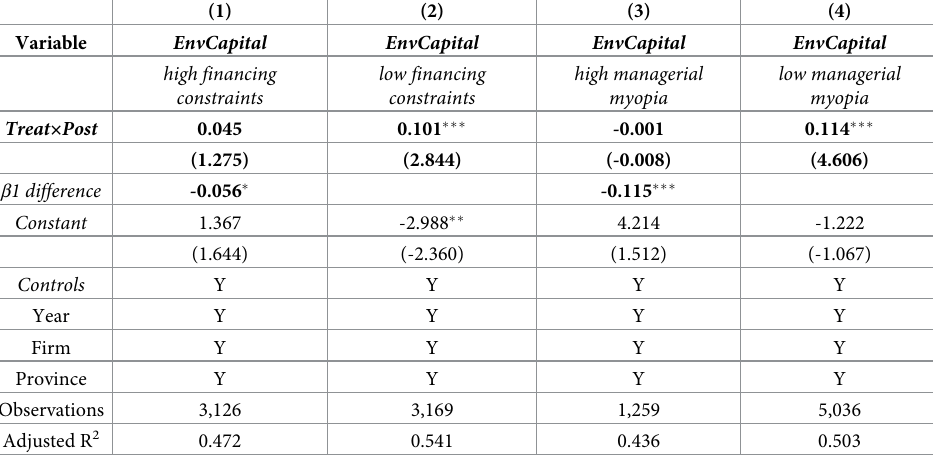
Table 9. Additional analysis: Internal resource